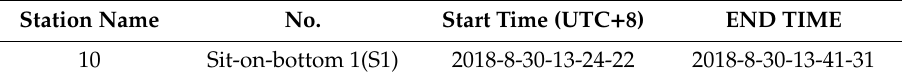
Table 4. The data description of the experiment in the Western Pacific.